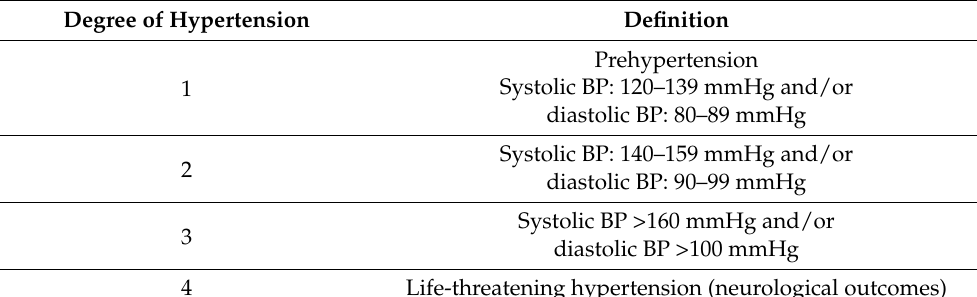
Table 1. Degrees of hypertension. Designed in accordance with Sikic et al.